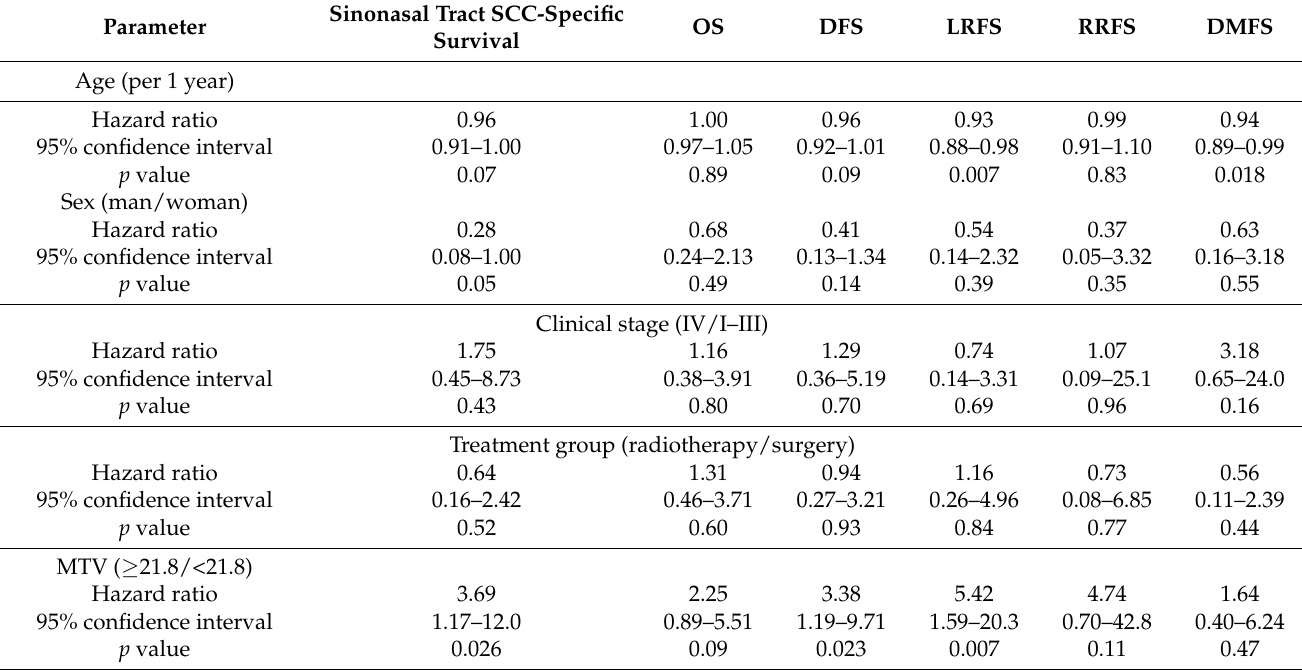
Table 3. Multivariable survival analysis in sinonasal tract SCC by Cox’s proportional hazards